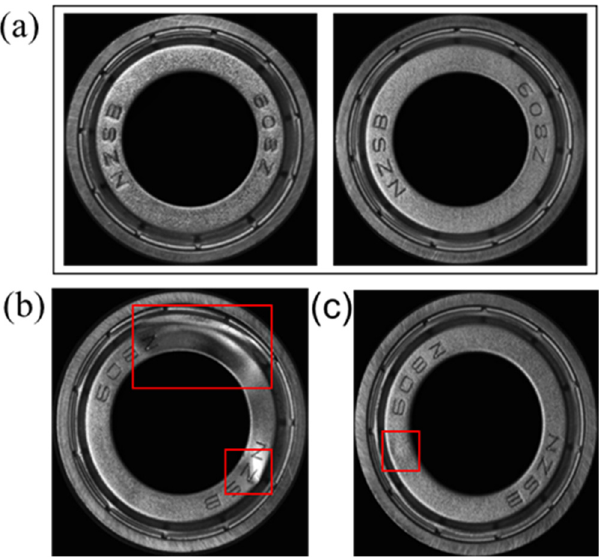
Figure 1. Challenges of bearing inspection from the industry. (The surface defect of the bearings is in the red box) ( a ) The data of two non-defective bearings exhibit large surface differences. ( b ) Defects of different sizes. ( c ) Small defects.